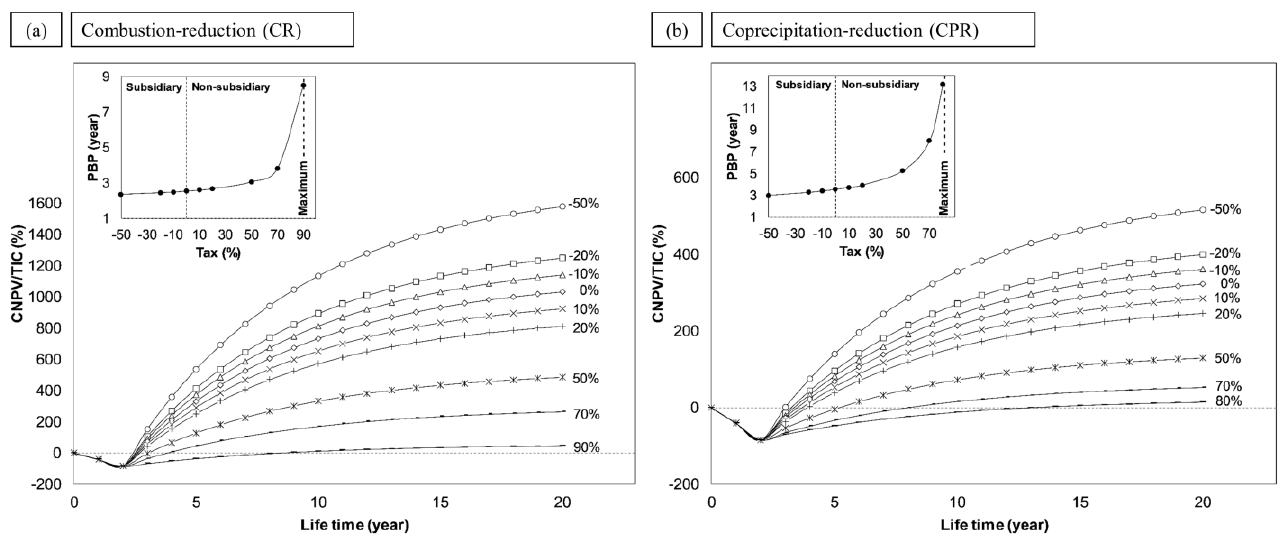
Fig. 13. CNPV/TIC curves in accordance to life time for (a) combustion-reduction (CR) and (b) co-precipitation-reduction (CPR) under various taxes. An insert image is the analysis of PBP based on